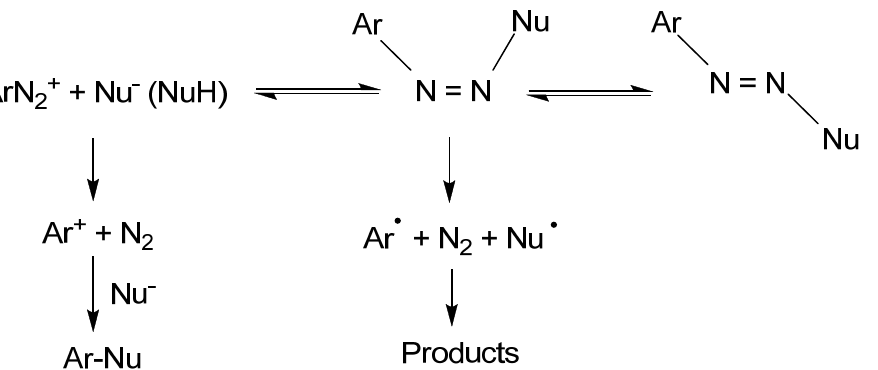
Scheme 3. Nucleophilic addition mechanism forming Ar-N=N-Nu adducts in the ( Z )- and ( E )- configurations. The competitive spontaneous decomposition of ArN 2+ is also included. Adapted from ref. [54] with permission, Copyright J. Wiley &